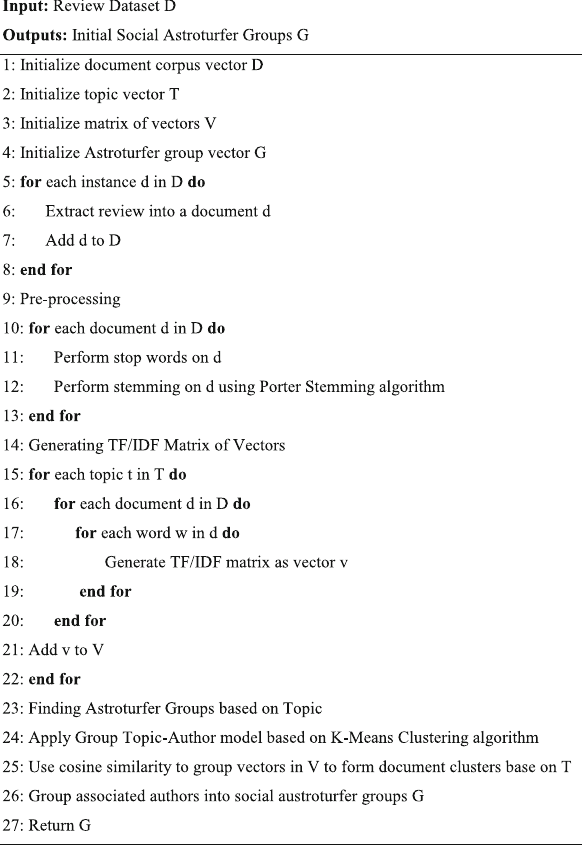
Table 1 Notations used in Group-Author model Notation